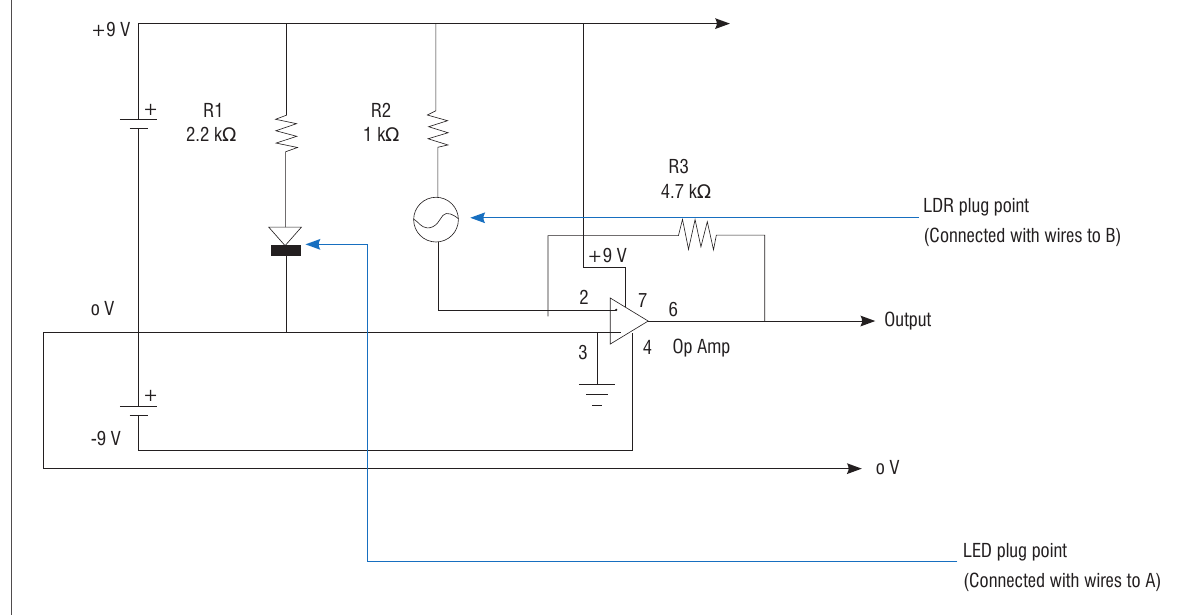
Figure 2: The electronic circuit diagram for the spectrophotometer, used for both the first prototype and the SpecUP (based on Tavener and Thomas-Oates 1 ).